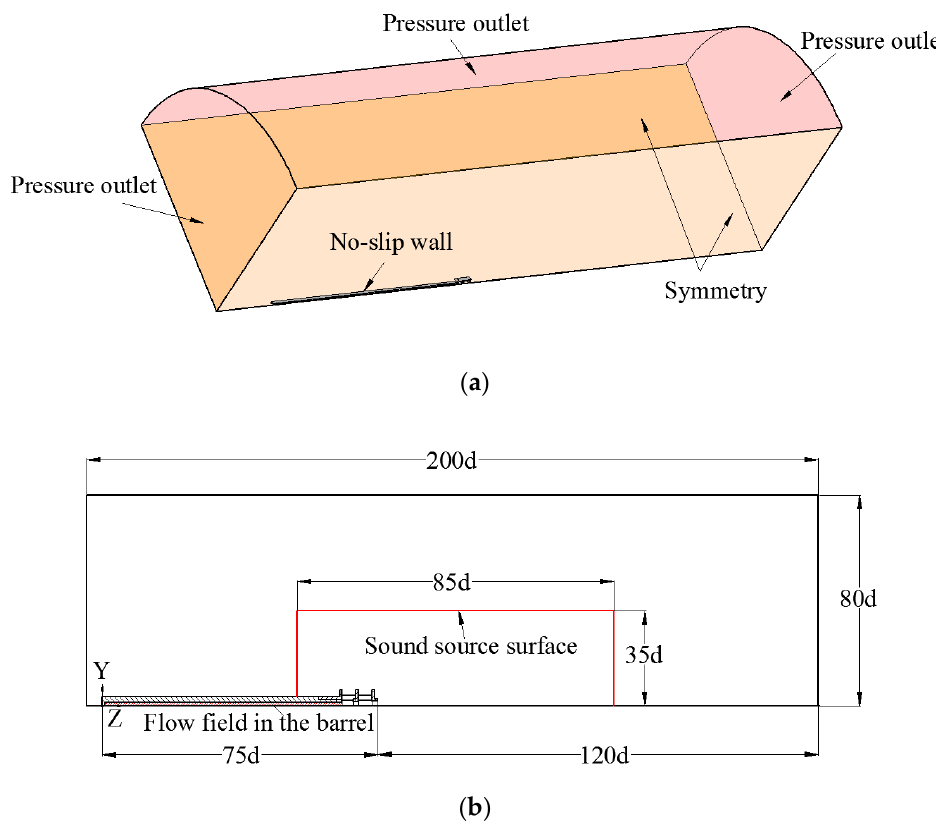
Figure 3. Computational domain and boundary conditions. ( a ) 3D view. ( b ) Section view.